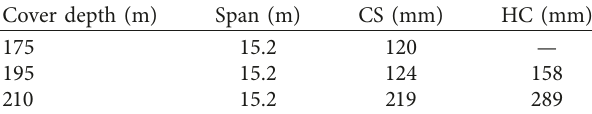
Table 2: Data of